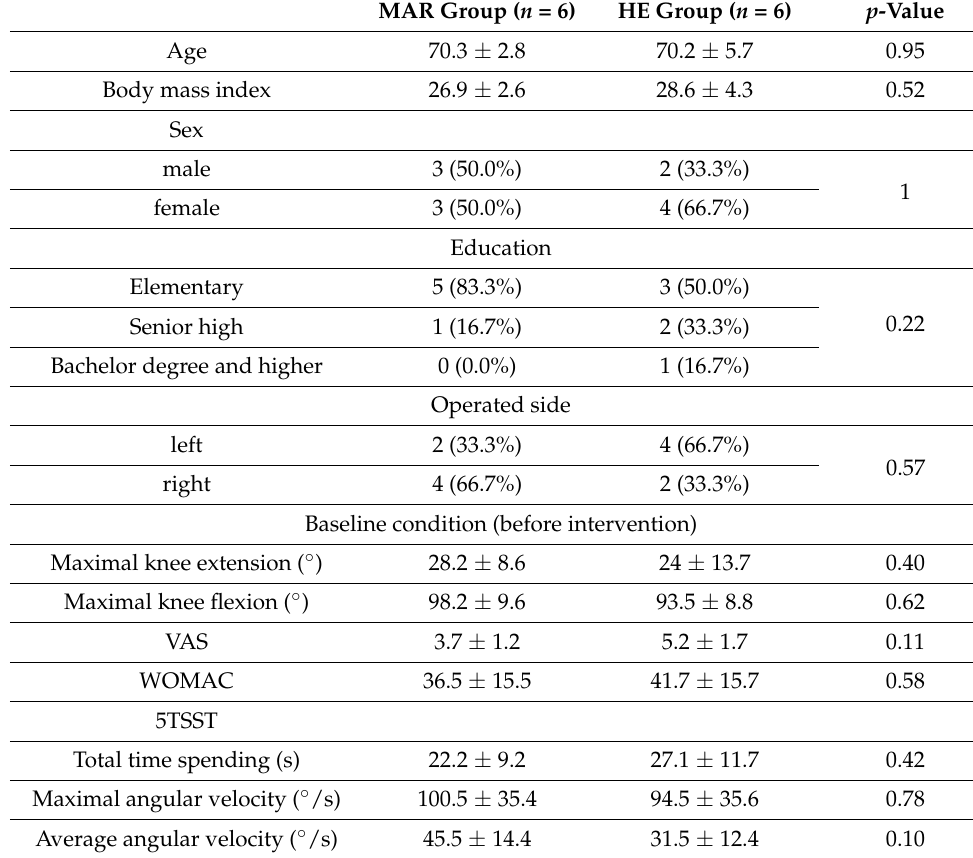
Table 2. Comparison of patient demographics between